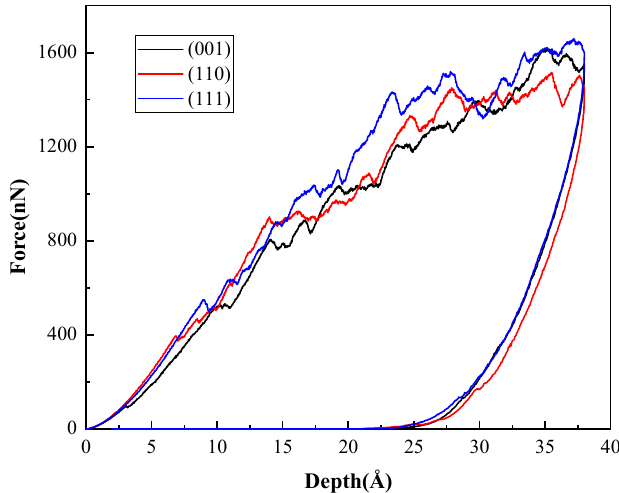
Figure 8. Sketch for slip systems under force along .